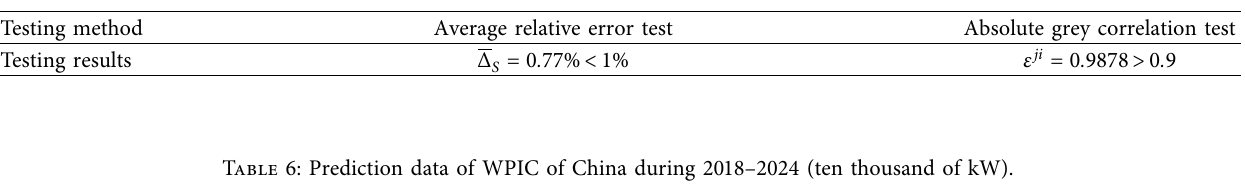
Table 5: Error test.